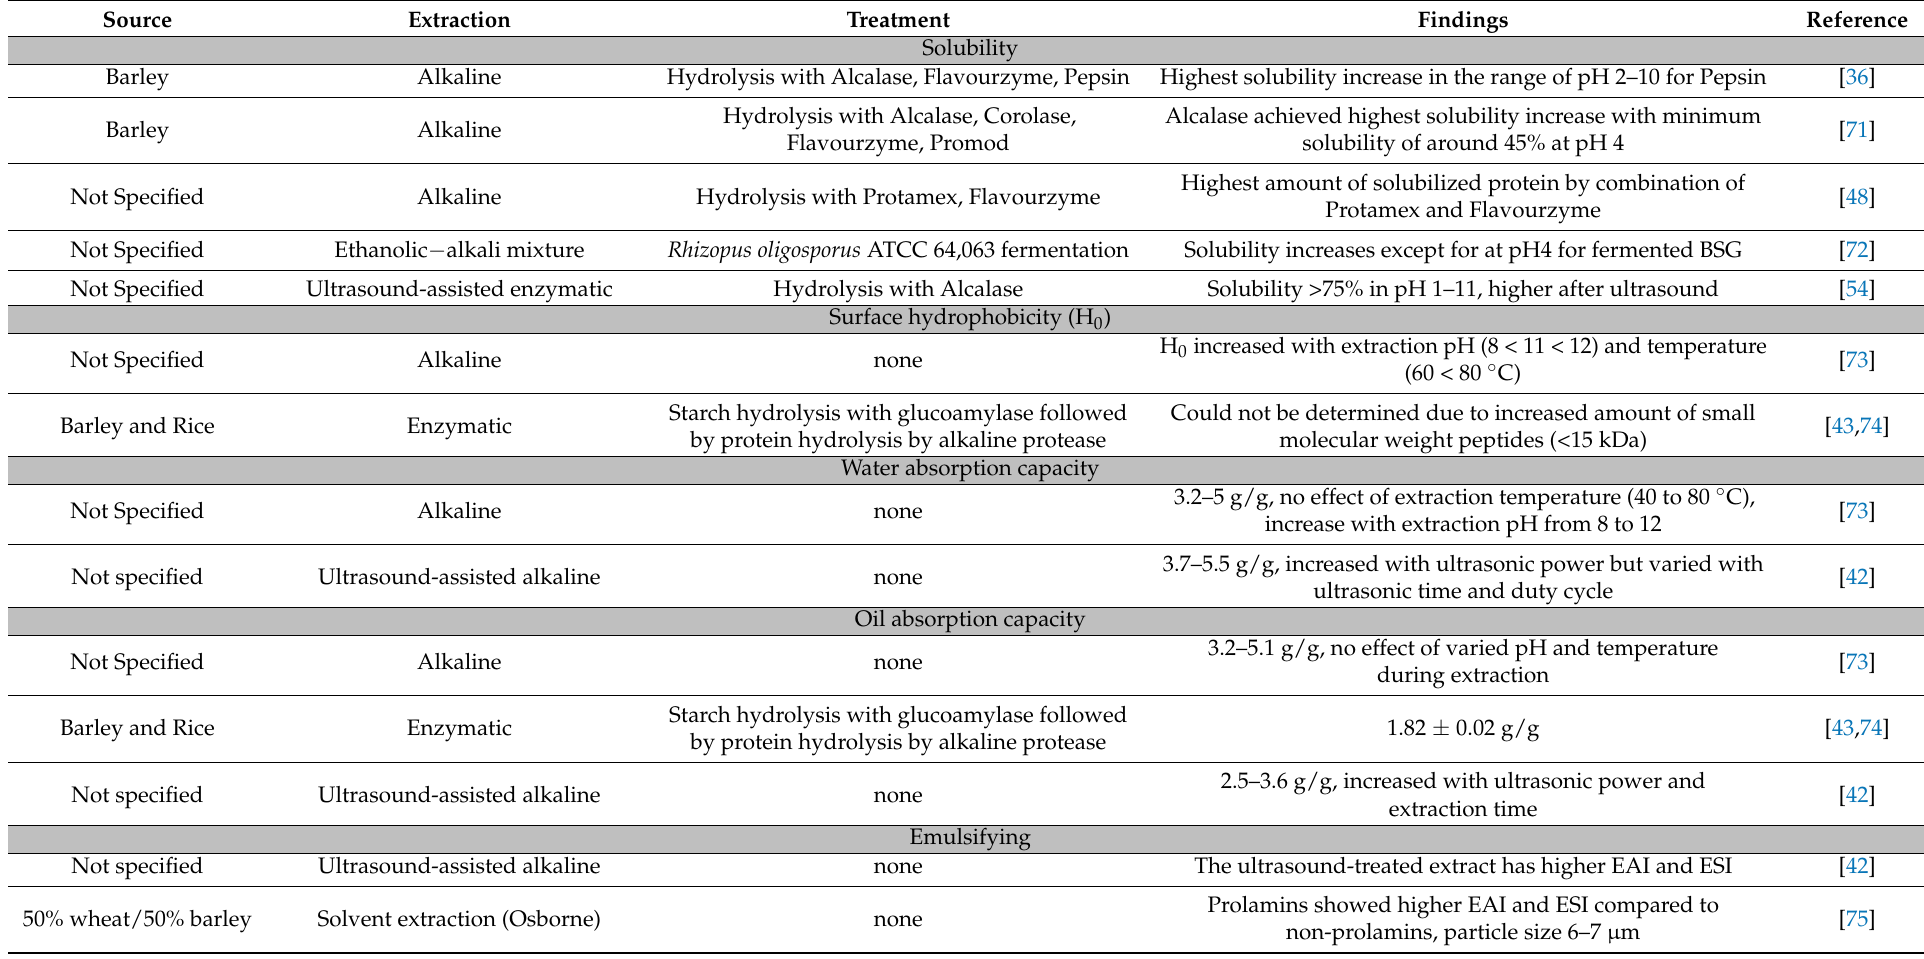
Table 5. Overview of selected studies that investigated physicochemical and functional properties of brewer’s spent grain